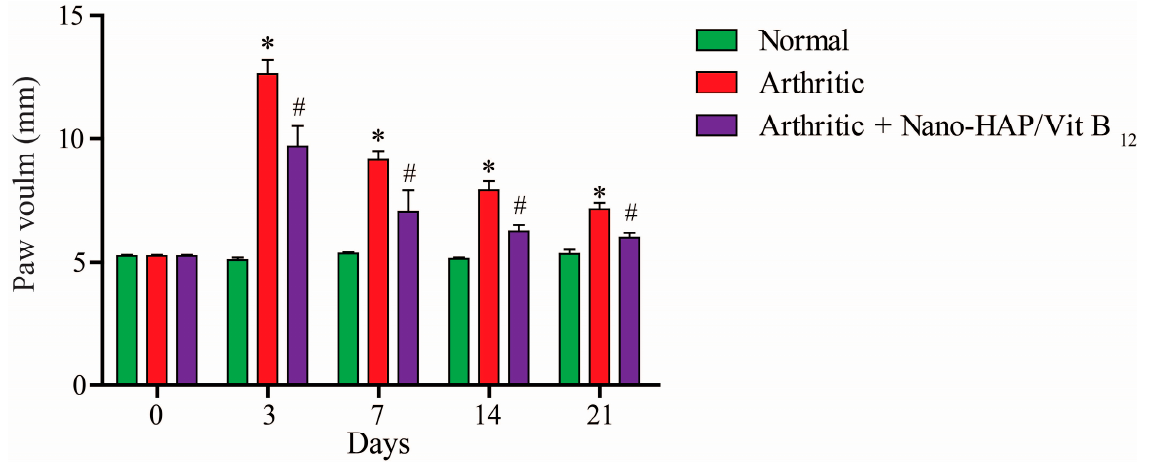
Figure 5. E ff ect of Nano-HAP/Vit B 12 on right hind paw size in CFA-induced arthritic rats (symbols indicate signi fi cant di ff erence at p < 0.05). * Signi fi cant compare to arthritic rats, # signi fi cant com- indicate significant difference at p < 0.05). * Significant compare to arthritic rats, # significant compare pare to arthritic rats treated with Nano-HAP/Vit B 12. to arthritic rats treated with Nano-HAP/Vit B 12